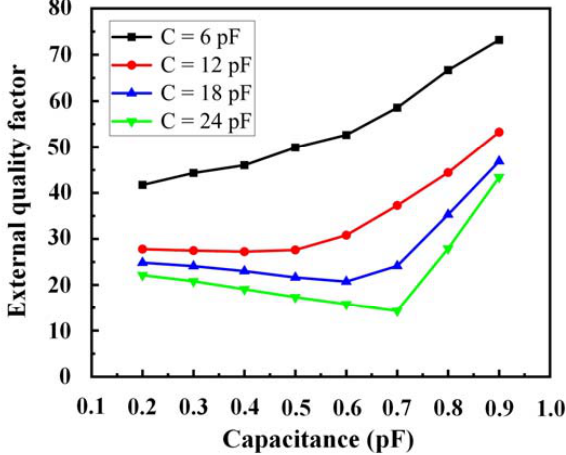
Figure 6. Variations in the simulated Q e with C v for different values of C.